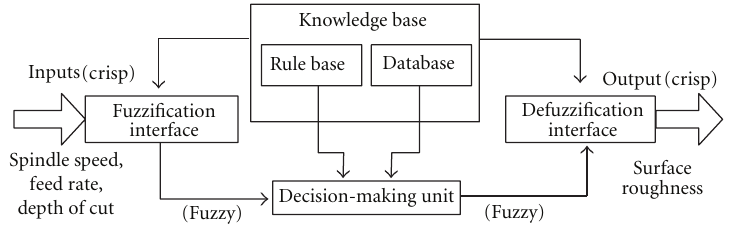
Figure 2: The structure of the fuzzy inference system used in this